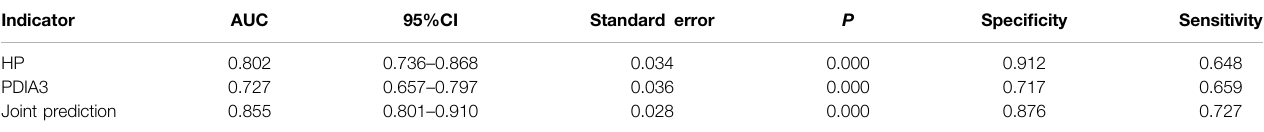
TABLE 2 | Value of HP and PDIA3 levels to assessment of colorectal cancer